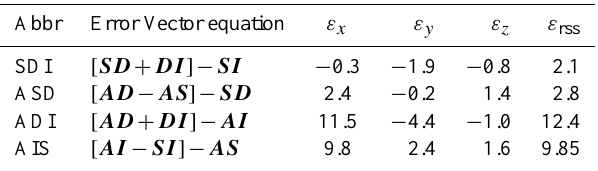
Table 6. Error vectors revealed through triangulation. All units are